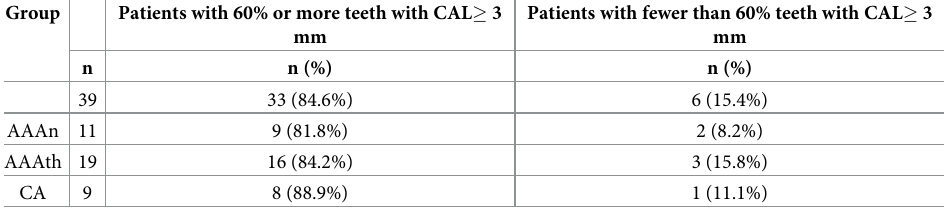
Table 6. The prevalence of periodontitis-atherosclerosis syndrome in the AAAn, AAAth, and CA